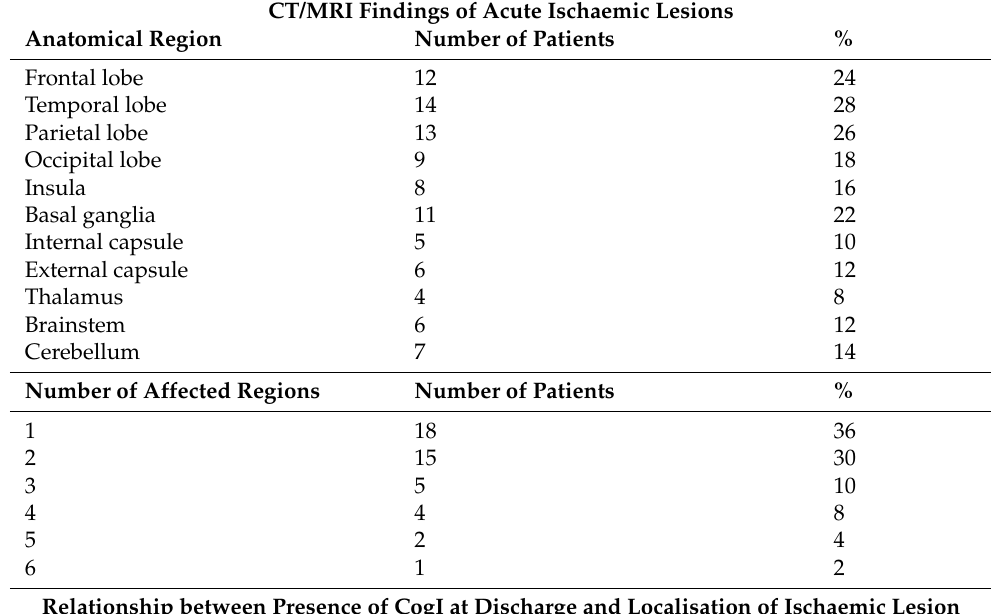
Table 4. Characteristics of analyzed group (n = 50) according to localization and number of new ischaemic lesions on CT/MRI